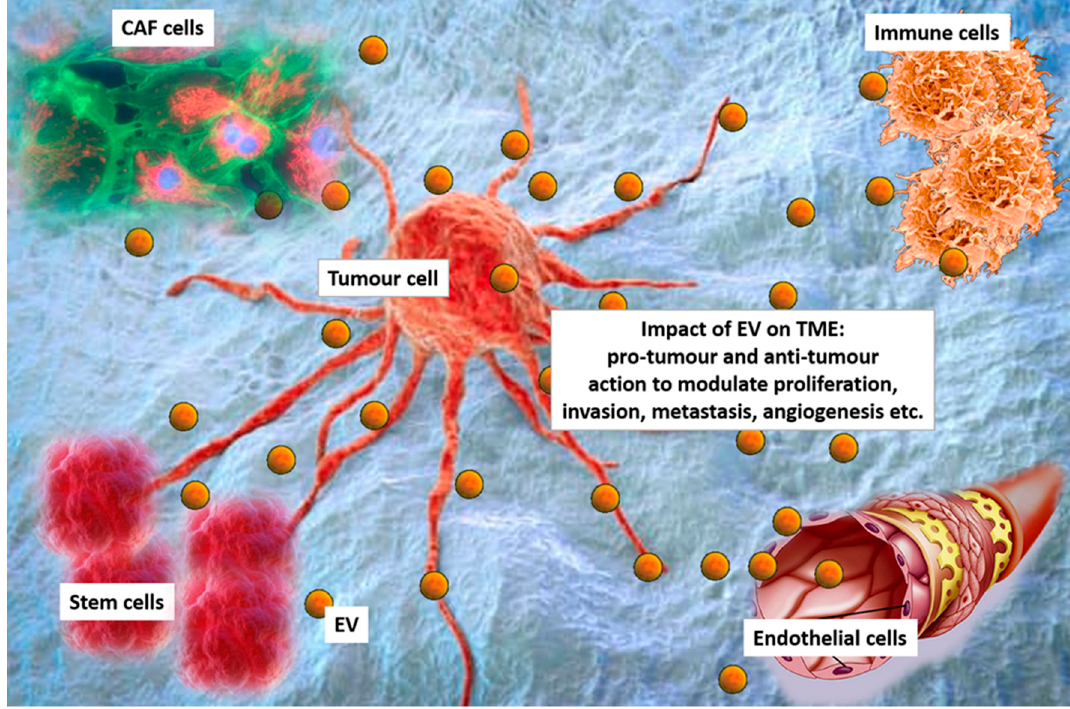
Figure 1. Extracellular vesicles (EV) in the tumour microenvironment (TME). Cancer cells, cancer associated fibroblasts (CAF), immune cells, stem cells and endothelial cells interact each other via EV in the TEM. EV can exert pro-tumour or anti-tumour effects to modulating proliferation, invasion, metastasis formation and